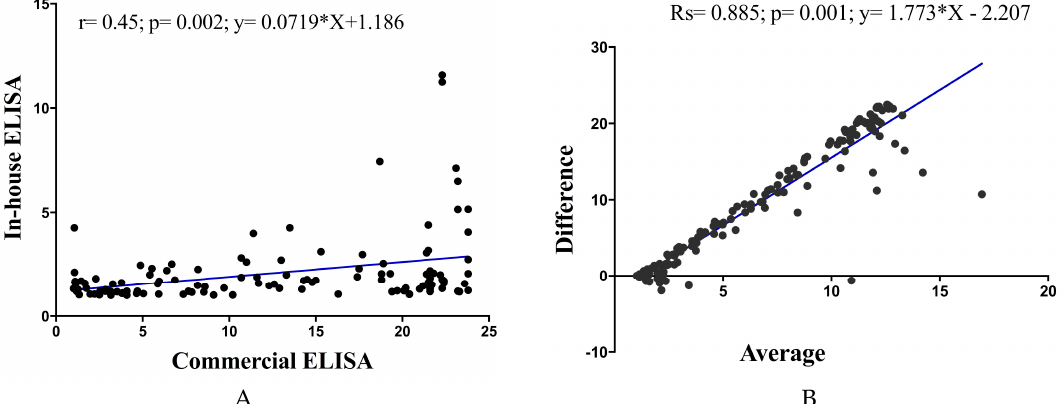
Figure 3. Correlation analysis between commercial and in-house ELISAs. Pearson correlation plots evaluated correlation between commercial and in-house ELISAs ( A ) and Bland–Altman plots ( B ). Blue line represents linear regression of data. Pearson correlation analysis showed a significant positive correlation of in-house versus commercial ELISAs (Pearson r = 0.45; p = 0.002; y = 0.07179 × X + 1.186). Bland–Altman plots showed significant correlation between the two ELISAs (Rs = 0.885; p = 0.001; y = 1.773 × X − 2.207). p value < 0.05 indicates a statistically significant correlation.